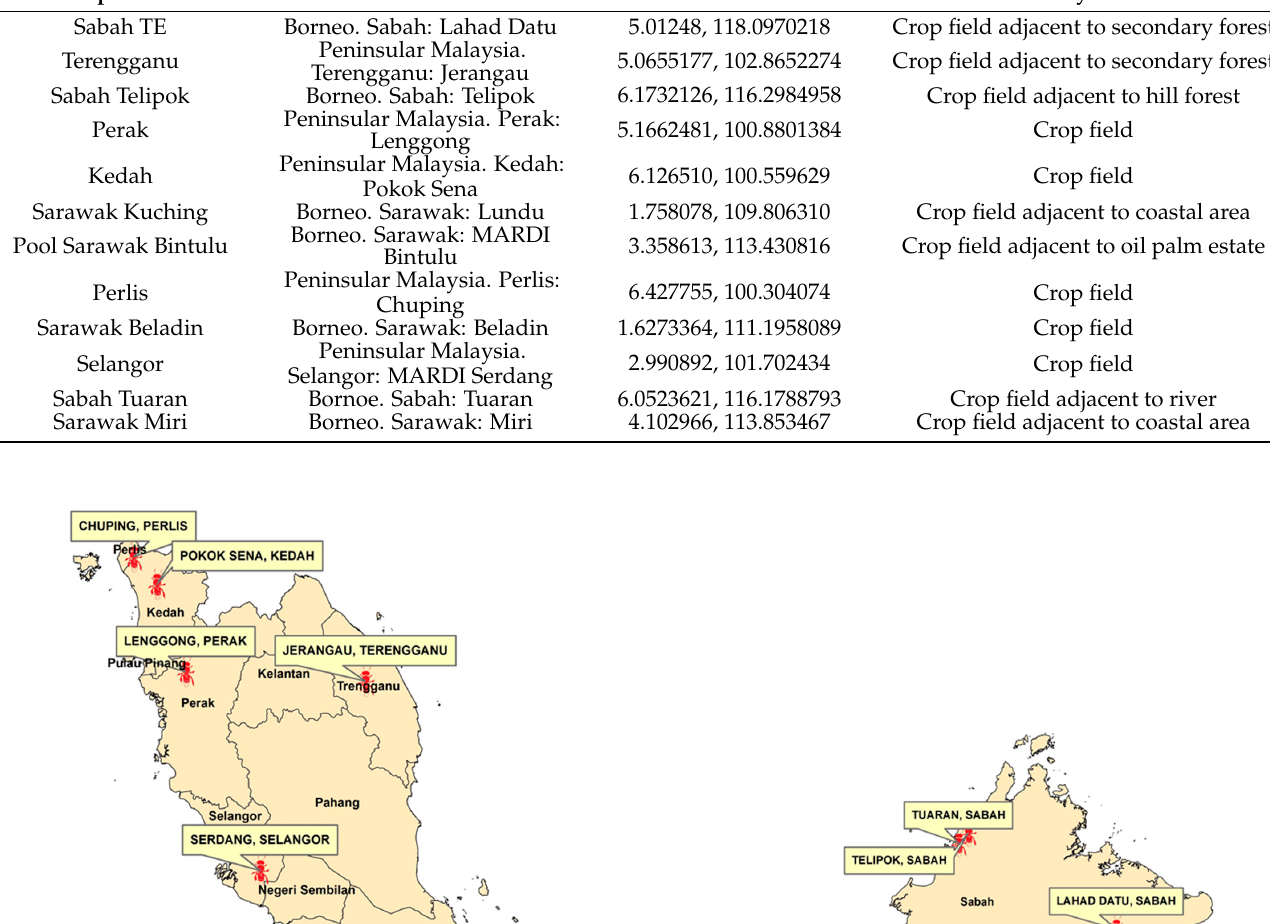
Table 1. List of samples used for metabarcoding analysis.